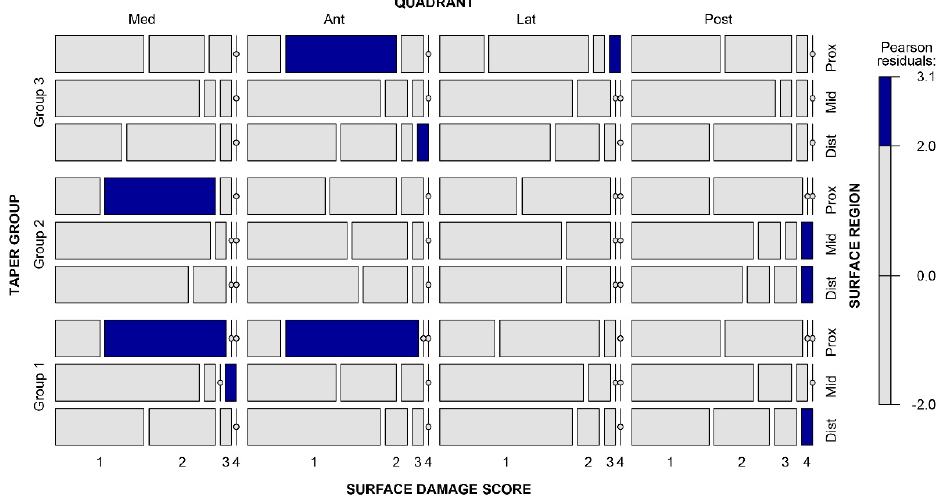
Figure 1. Mosaic plot showing the frequency of surface damage scores for the 12 regions of the taper surface. The tile width represents the number of the score value in each cell. The colour of each tile corresponds to the value of Pearson residuals. The bar on the right shows the correspondence between colours and values of Pearson residuals and the cut-off points.